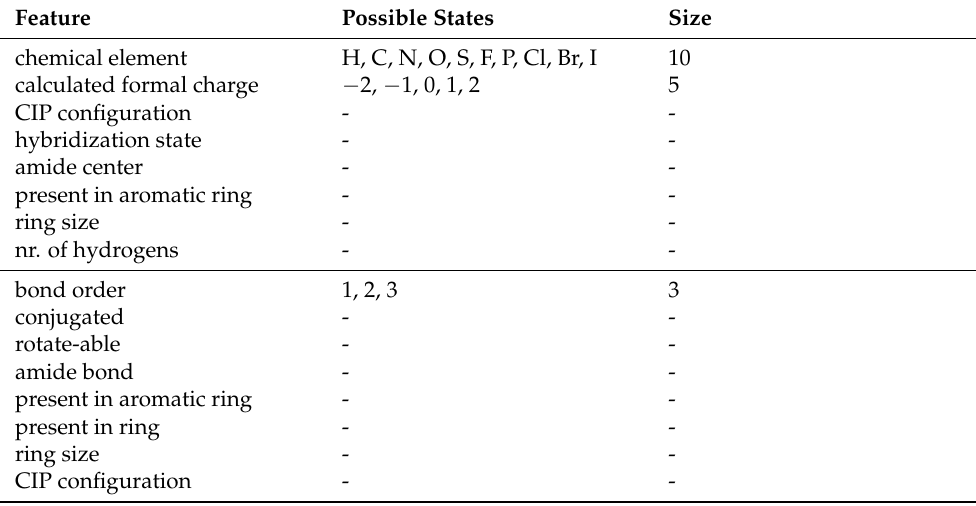
Table A3. Node and edge featurization of type 5. Each node or edge featurization vector consisted of a concatenation of the different one-hot encoded or floating point feature vectors according to their possible states (if present) and corresponding size-15 for nodes and 3 for